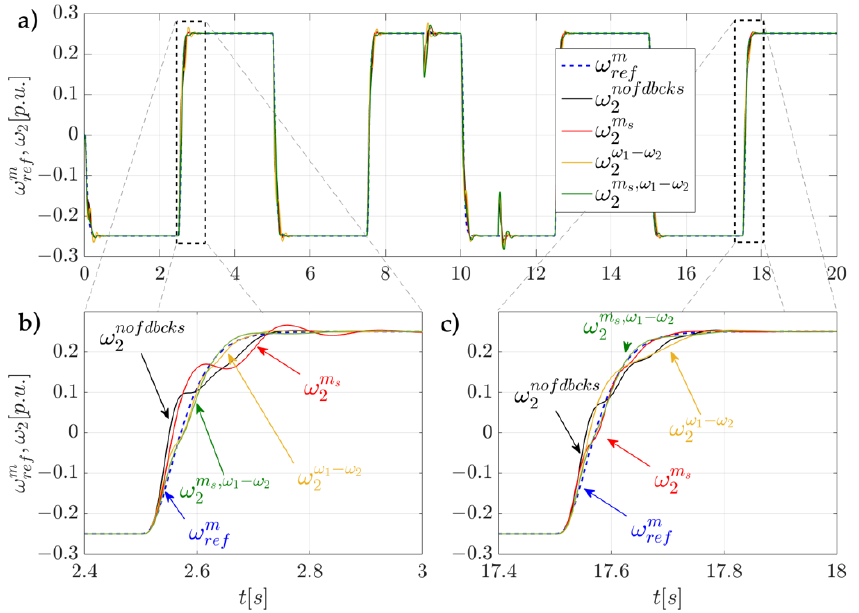
Figure 16. Comparison of speeds ( ω ref and ω 1 ) transients obtained for different connections of feedbacks ( a ), the initial part of the simulation ( b ), the final of the simulation ( c ).